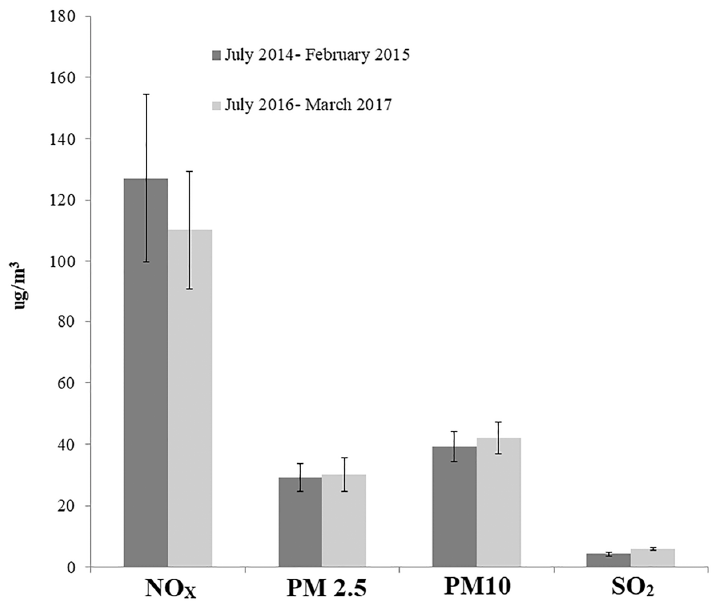
Figure 12. Main pollutants average concentrations for Milan monitoring sites (data from ARPA